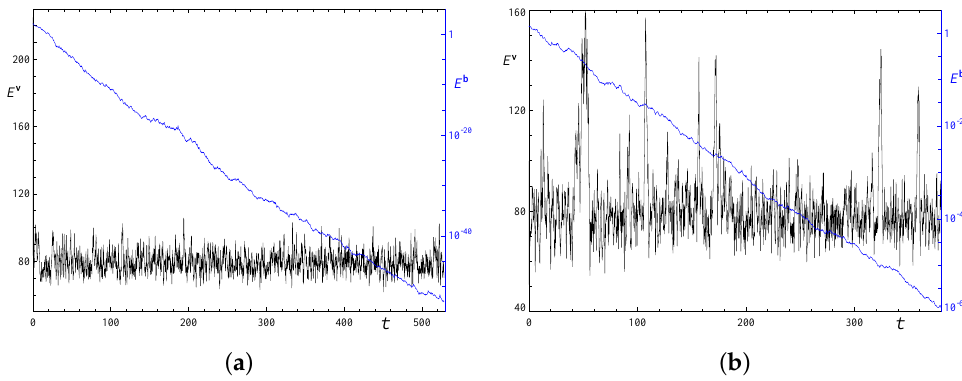
Figure 25. Temporal behaviour of the kinetic (left vertical axis, black line) and magnetic (right vertical axis, blue line) energies in the double-period runs 4 x 4.2 (a) and 2 x 4.2